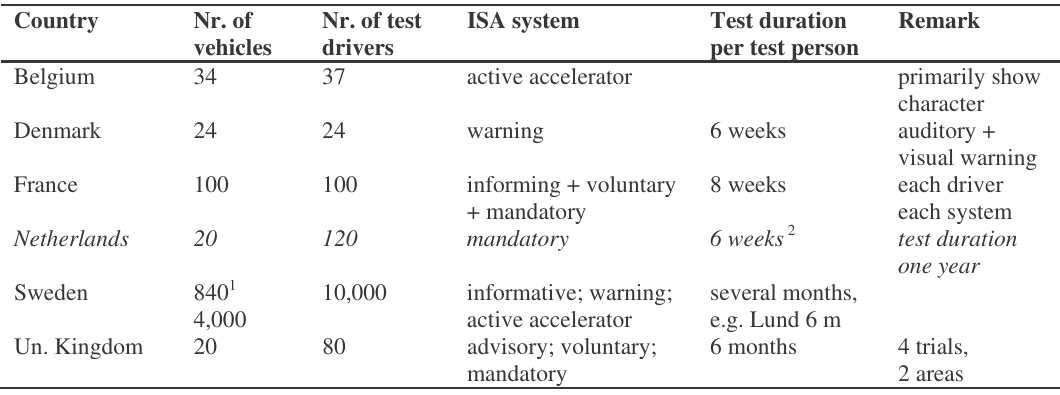
Table 1. Indicative overview of scale of ITS field trials in Europe Country Nr. of Nr. of test ISA system Test duration vehicles drivers 34 37 active accelerator primarily show